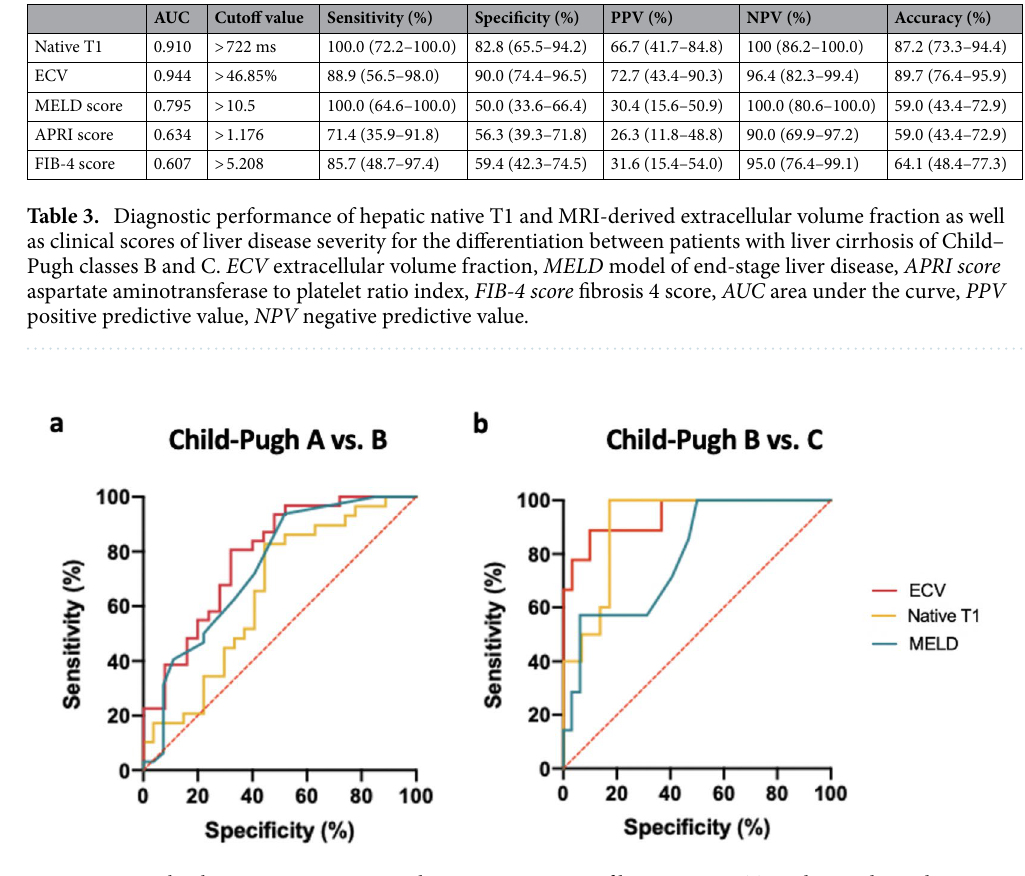
Figure 4. Graphs show receiver operating characteristic curves of hepatic native T1 and MRI-derived extracellular volume fraction (ECV) as well as clinical scores of liver disease severity for differentiation between different Child–Pugh A and B classes ( a ) and Child–Pugh B and C classes ( b ). ( a ) Curves are given for hepatic native T1 (area under the curve [AUC]: 0.651), hepatic ECV (AUC: 0.785), MELD (AUC: 0.740). ( b ) Curves are given for hepatic native T1 (AUC: 0.910), hepatic ECV (AUC: 0.944), MELD (AUC: 0.795). ECV extracellular volume fraction, MELD model of end-stage liver